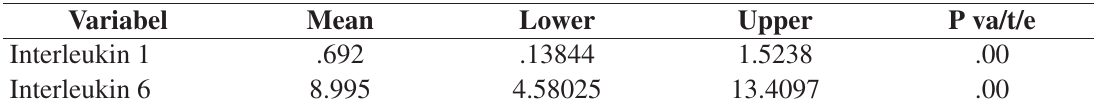
Tabel 2. Perbedaan Ekspresi Interleukin 1 dan interleukin 6 antara Kelompok Perawatan